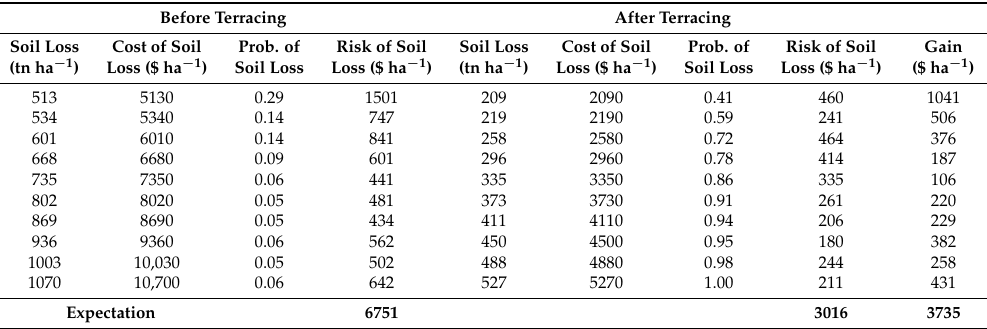
Table 2. Statistics of cumulative distribution for soil loss resulting from model uncertainty. Before Terracing After Terracing Soil Loss (tn ha − 1